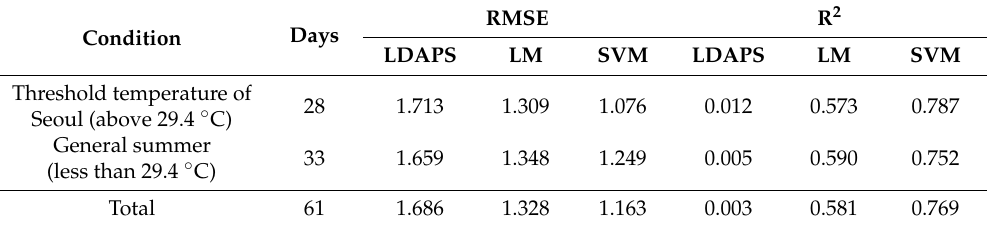
Figure 11. Time series of observed air temperature and precipitation at the Seoul weather station (SWS) during 23–26 August. Table 4. Evaluation results (mean RMSE and R 2 ) according to observed air temperature at 52 KMA